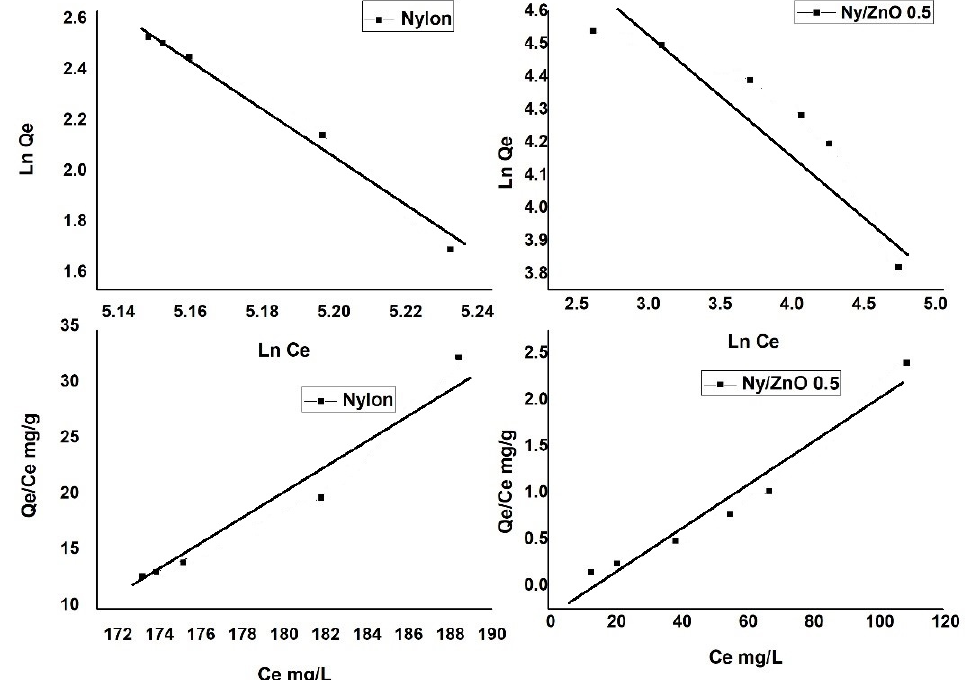
Figure 9. Langmuir and Freundlich model of adsorption for methylene blue of the nylon and Ny/ZnO 0.5 (MB concentration = 200 mg/L, nanocomposite content = 20 mg/20 mL, T = 25 ◦ C and t = 60